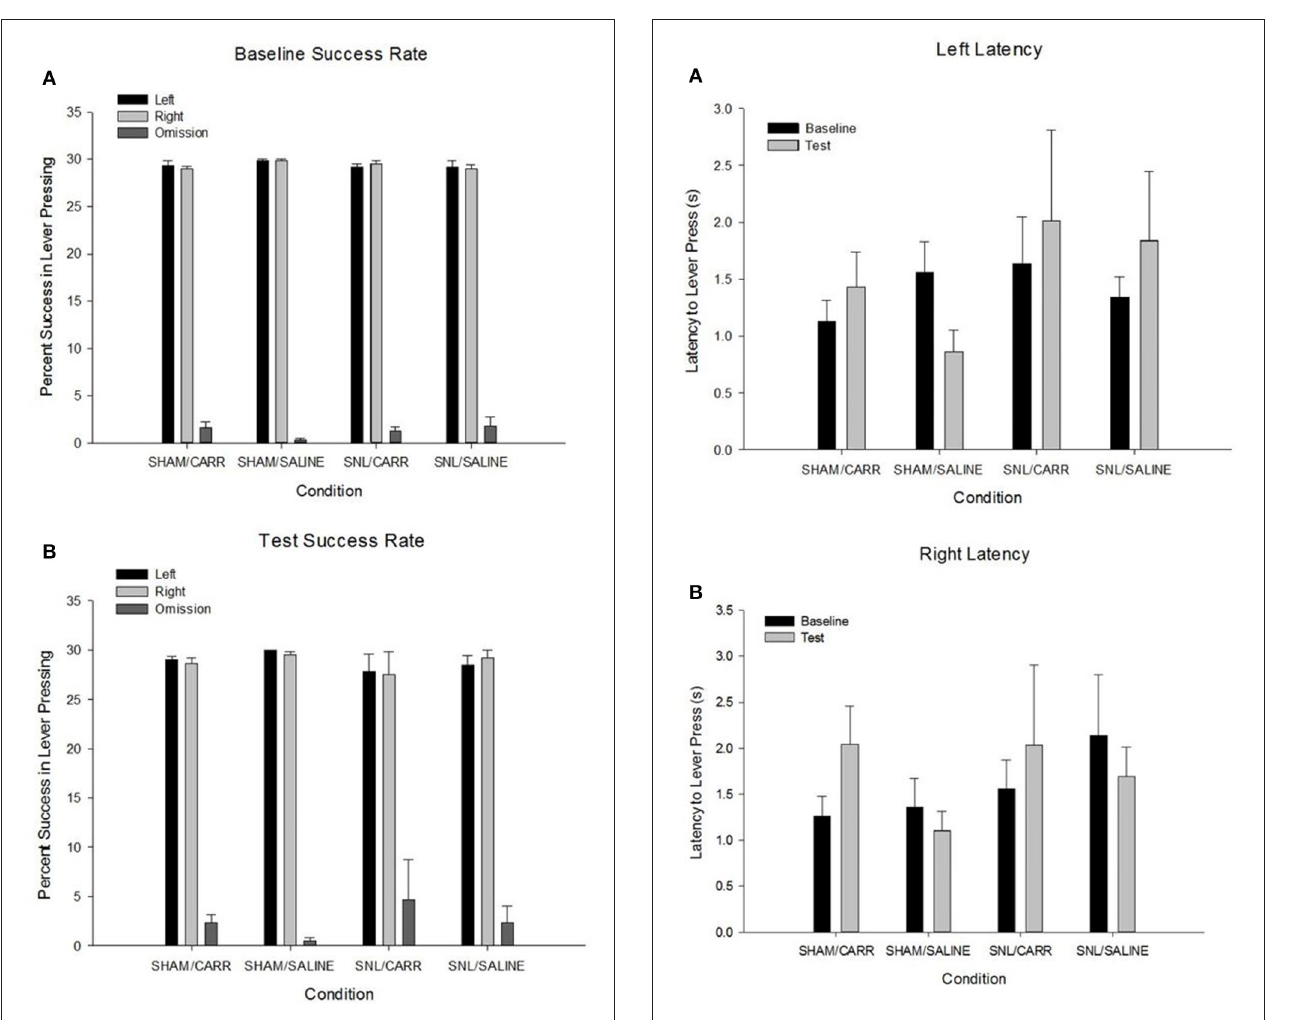
FIGURE 3 | Percent success ( ± SEM) in lever-pressing for left and right levers and pooled left and right omissions across pain conditions for baseline (A) and test days (B) . Success rates were quantified by using an individual number of lever-presses for the paradigm on test day and dividing by the total number of trials for each side (30). There were no differences in success rates for lever-pressing or omissions to the AAP.